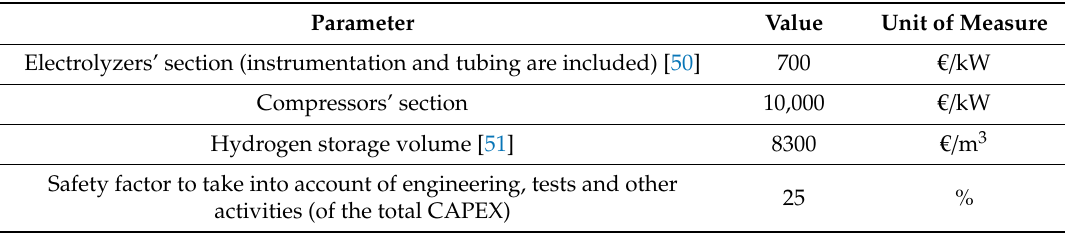
Table 5. Capital expenditure (CAPEX)